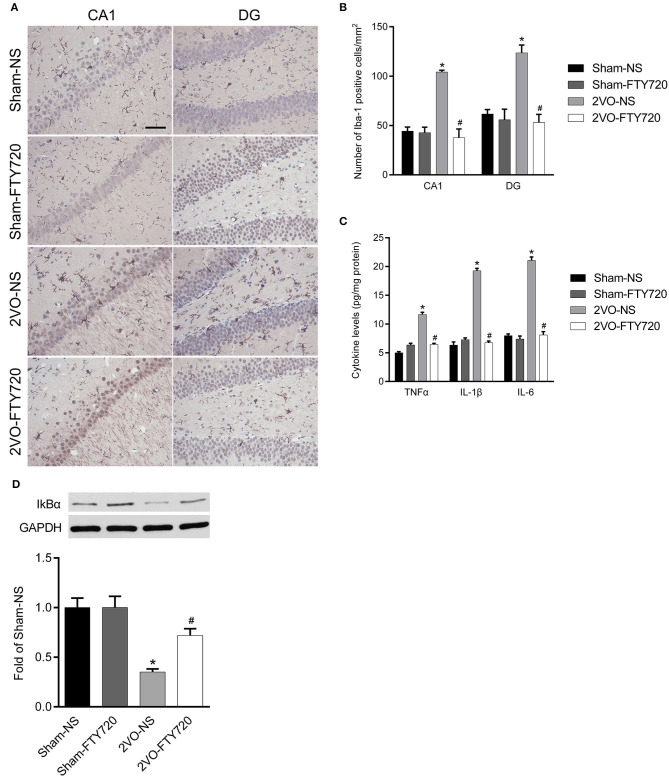
The modulation of FTY720 to CCH-induced hippocampal neuroinflammatory response. (A) Representative immunohistochemistry images of Iba-1 positive cells in the hippocampus of rats (Scale bar = 50 μm, 400×). (B) Quantitation of Iba-1 positive cells in the hippocampus CA1 and DG regions with bar graph. (C) Quantitative bar graph of pro-inflammation cytokines expression in the hippocampus. (D) Representative IkBα western blot bands in the hippocampus of animals. Protein level was normalized to the loading of GAPDH and expressed as fold of sham-NS. Data were shown as mean ± S.E.M. n = 4–5 rats for each group. *p < 0.05 compared with the sham-NS group. #p < 0.05 compared with the 2VO-NS group.